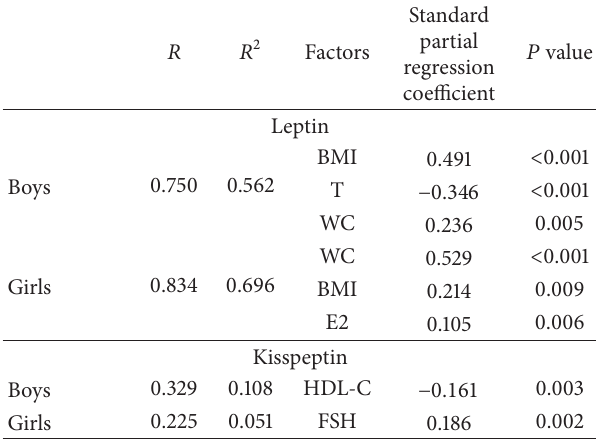
Table 2: Correlation analysis of serum leptin and kisspeptin levels with other clinical items.